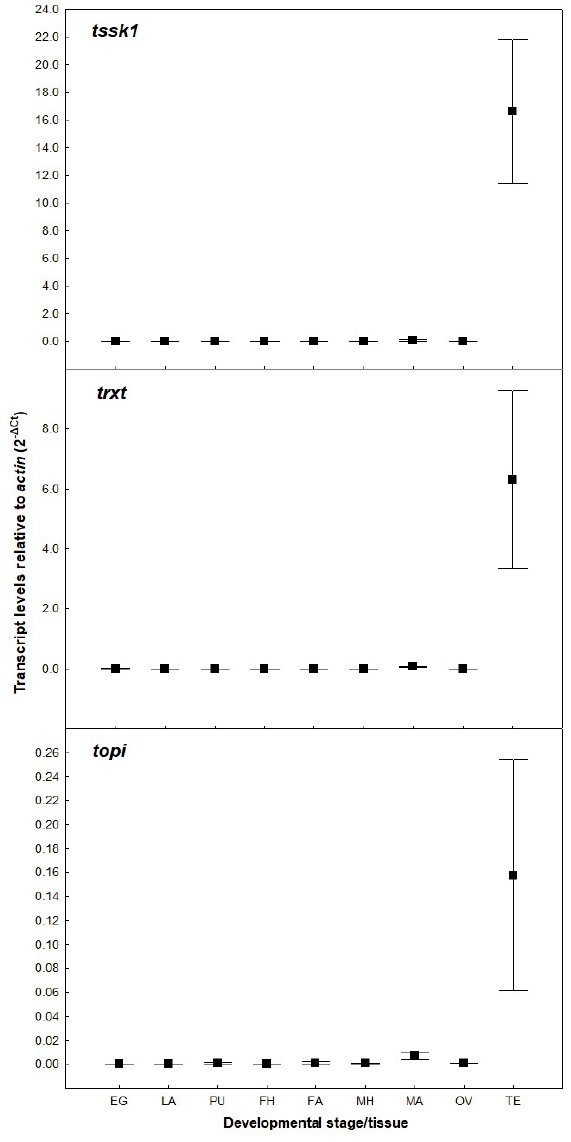
Figure 1. Transcript levels of putative spermatogenesis genes, relative to actin , in different tissues